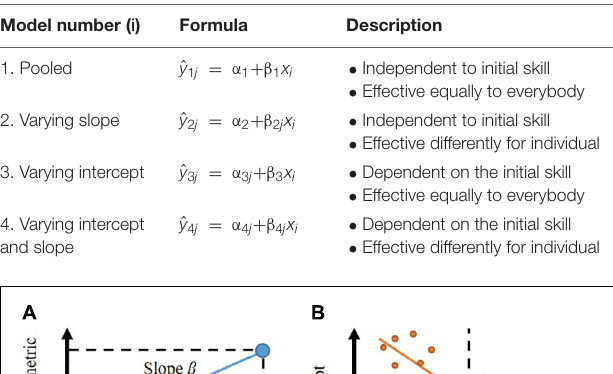
TABLE 1 | Models of the skill level change.